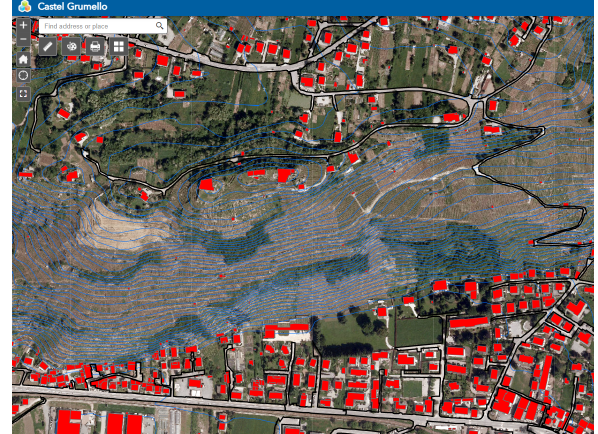
Figure 13: An overview of the area with some shapefile at terri- torial scale loaded into the web